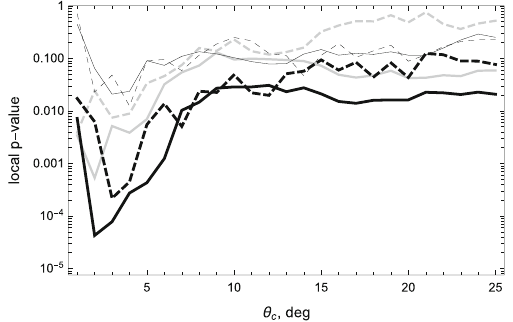
Fig. 6 The local p value as a function of the free parameter θ c and the choice of the disk (dashed) or Gaussian (full) smoothing. Thin black lines – VHE hardenings, gray lines – UHE correlations, thick black lines – combined